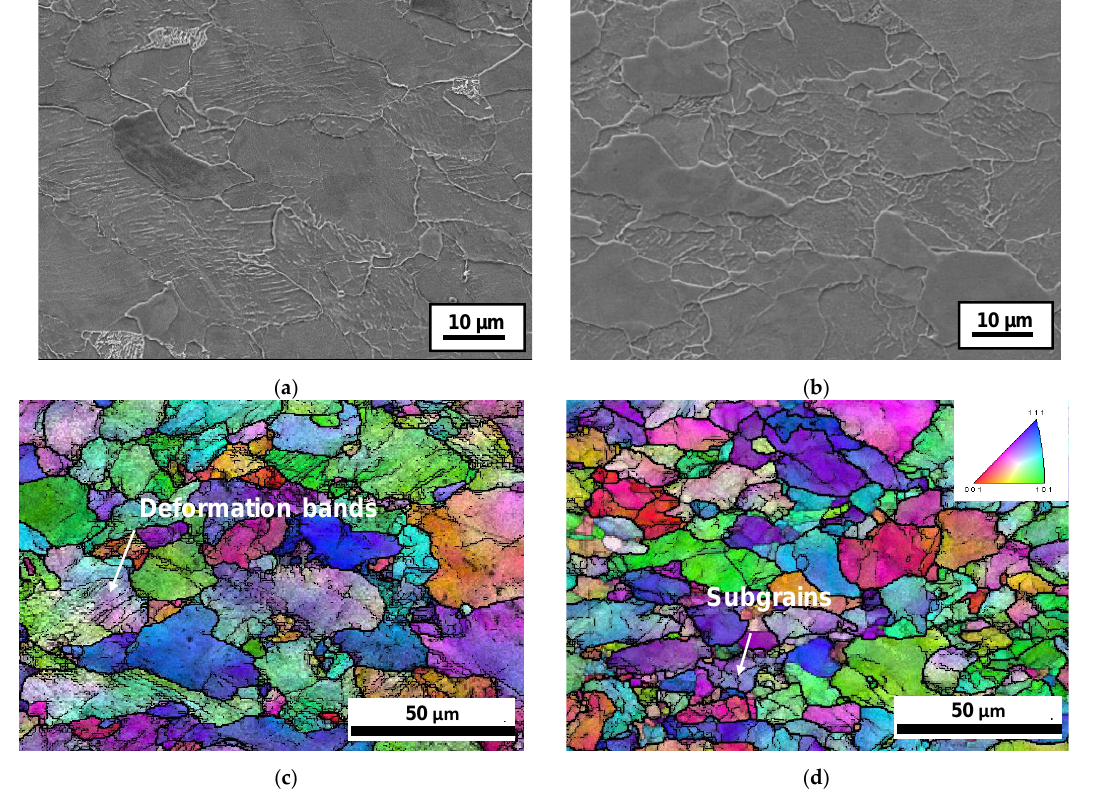
Figure 7. ( a , b ) FEG-SEM micrographs and ( c , d ) inverse pole figure (IPF) + image quality (IQ) maps corresponding to the NbV and Tdef75: ( a , c ) Cycle A (transformation from recrystallized austenite) and intercritical deformation temperature of 720 ◦ C and ( b , d ) Cycle B (transformation from deformed austenite) and deformation temperature of 740 ◦